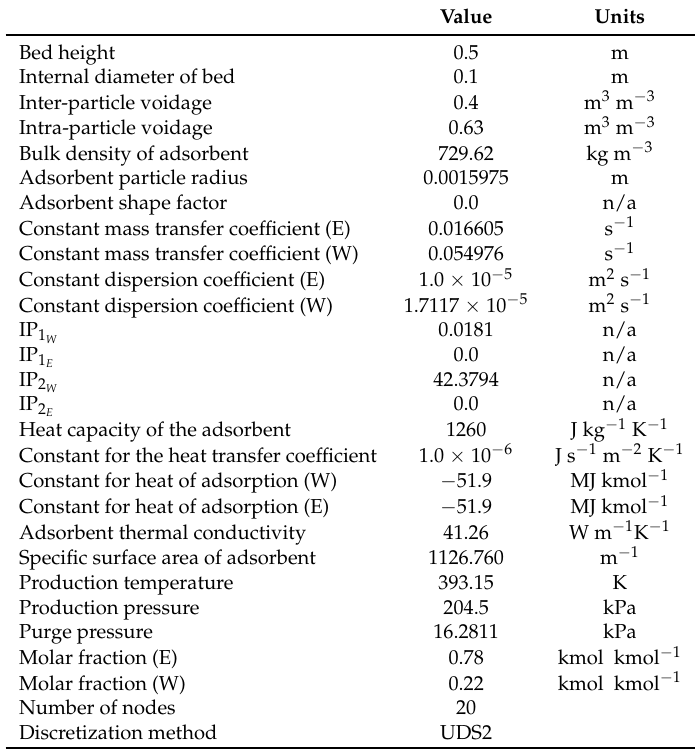
Table A9. Specification of required parameters to create the model simulation